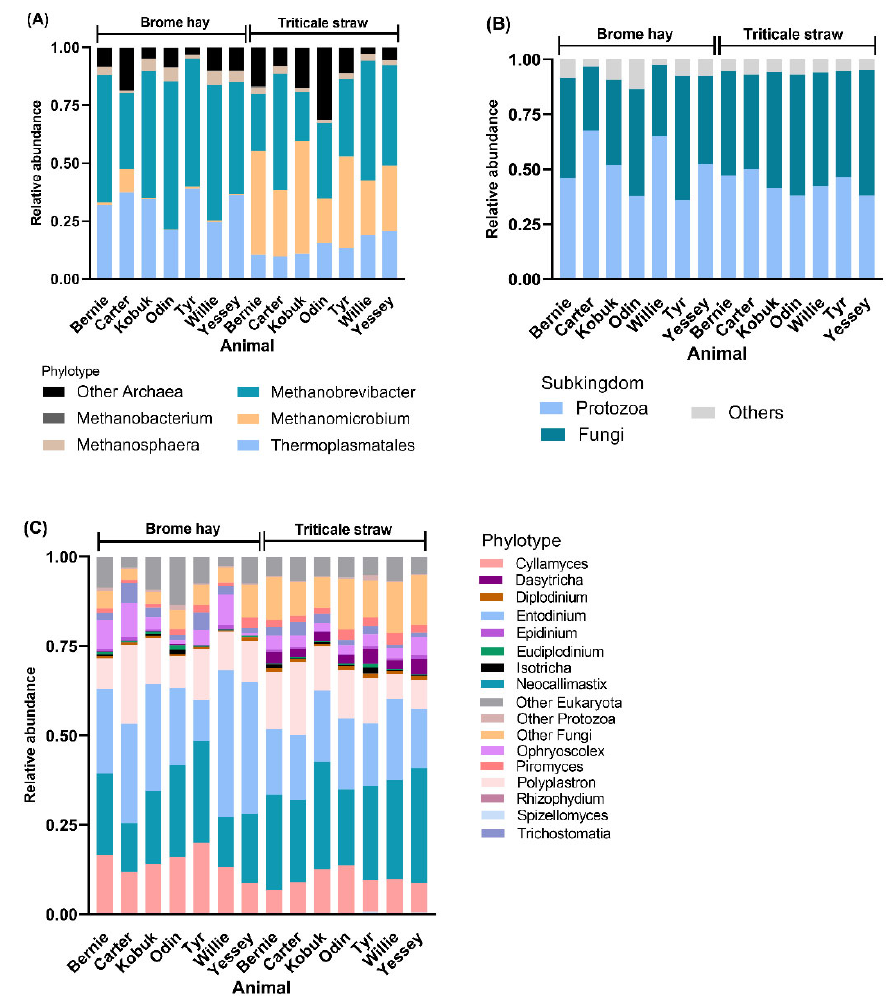
Figure 3. Contribution of archaea and eukaryotic in solid phase rumen contents from muskoxen in two groups crossover fed either triticale straw (TS noted) or brome hay (BH noted); ( A ) The relative abundance of archaeal phylotypes of the muskoxen rumen on either triticale straw or brome hay during fall, and ( B ) the composition eukaryotes of the muskoxen rumen, as well as ( C ) the distribution of eukaryotic community at the genus level in solid phase rumen